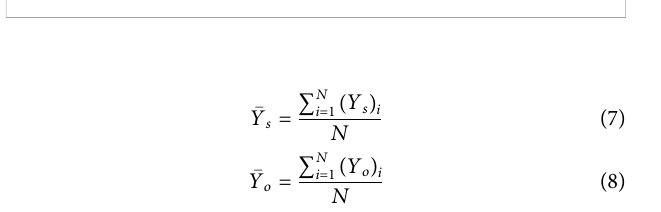
FIGURE 2 Annuallakewaterlevel(blackcircles)andmeanvauleof1961 – 2019 (3,194.33 m) lake water level (black solid line) based on lake water level measured at the hydrological station. Also included are the linear trend from1961to2004(redline),andthelineartrendfrom2004to2019 (blue